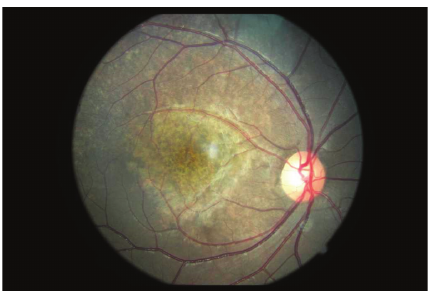
Figure 1: Salt and pepper retinopathy at the posterior pole in congenital rubella syndrome.